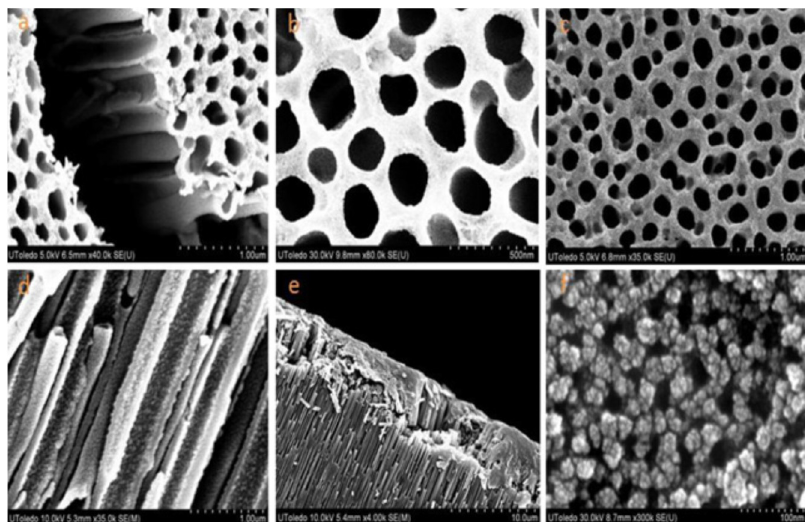
Figure 5. SEM images of ( a ) the top view of the TiO 2 nanotubes, ( b ) the surface morphology of the TiO 2 nanotubes and Ag particles, ( c ) the top view of the CoO nanotubes, ( d ) the cross-section of the TiO 2 -CoO nanocables, and ( e ) the cross-section of the TiO 2 -CoO nanocables after sputtering Au coating and ( f ) the top view of the TiO 2 -CoO nanocables after sputtering Au coating. Reproduced with permission from [91], © 2010, Elsevier B.V.